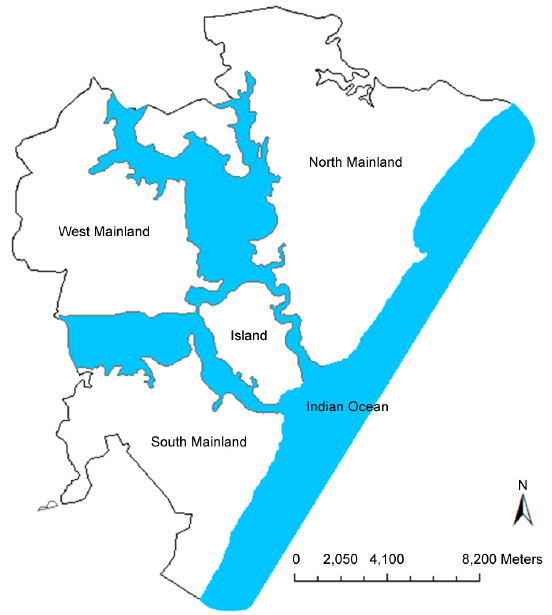
Figure 1. Map of Mombasa City showing the four main zones in the study area.